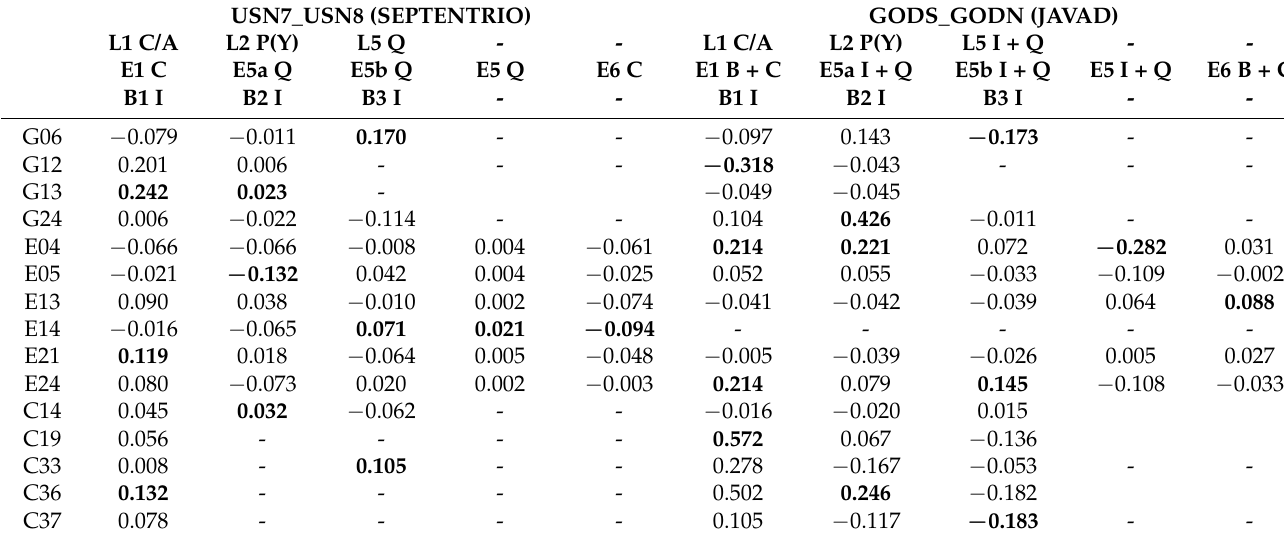
For Galileo, pseudorange biases had a slight increase on each frequency for SEPTEN-